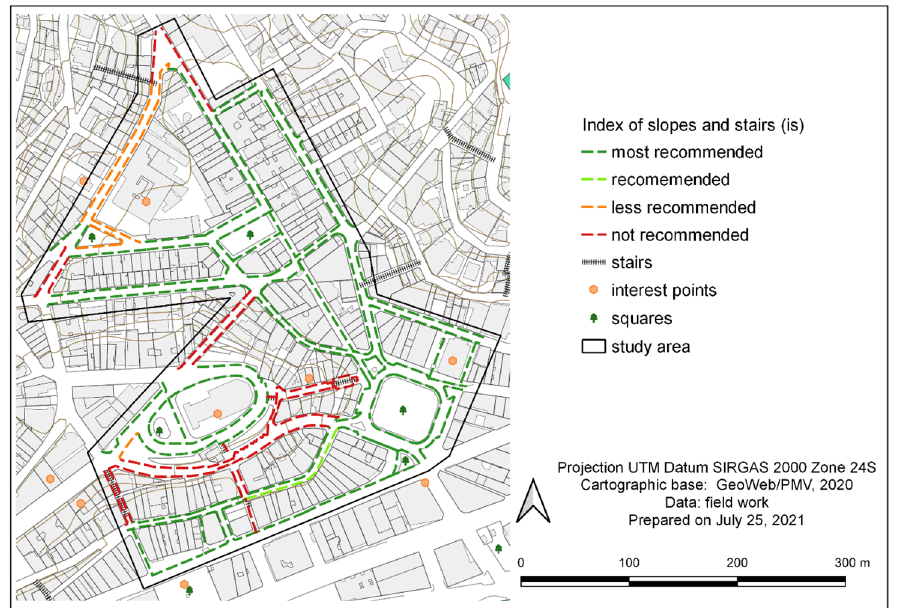
Figure 8. Map of stretch classifications within the study area, according to the index of slopes and stairs (‘is’).